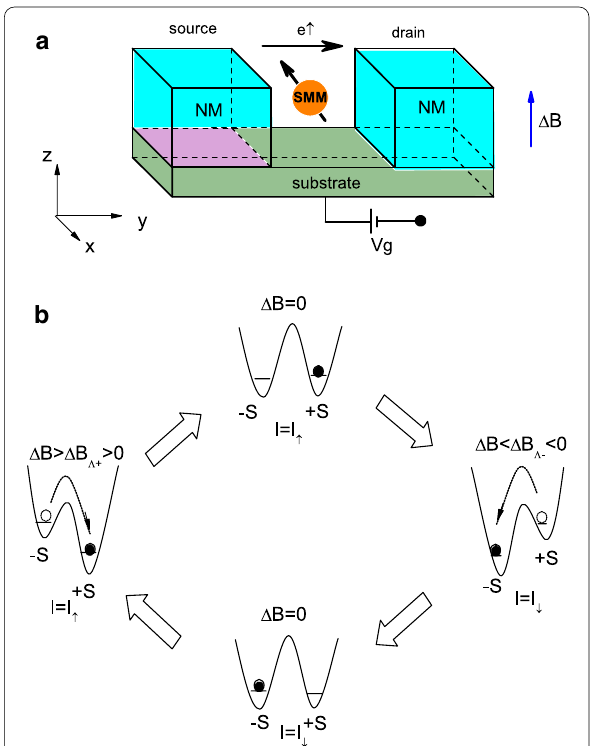
Fig. 1 a Schematic diagram of a spin filter or spin memory consisting of an SMM coupled to a pair of nonmagnetic electrodes. b Schematic illustration of the switching of the SMM’s magnetization and the spin polarization of the tunneling current by means of external magnetic